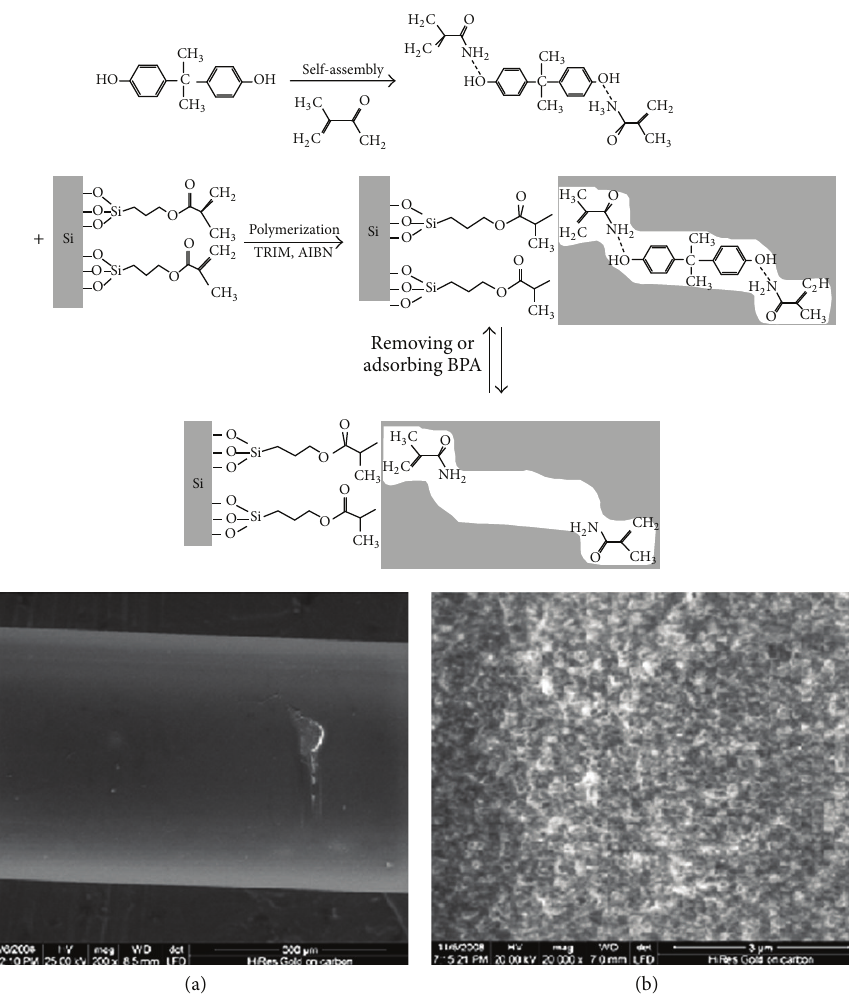
Figure 9: The preparation process of BPA-imprinted MIP coating on the silylated wall of the silica capillaries. Schematic representation of BPA-imprinted MIP coating on the silylated wall of the silica capillaries and Scanning electron micrographs of MIP coating of the fiber. (a) × 200, (b) × 20000